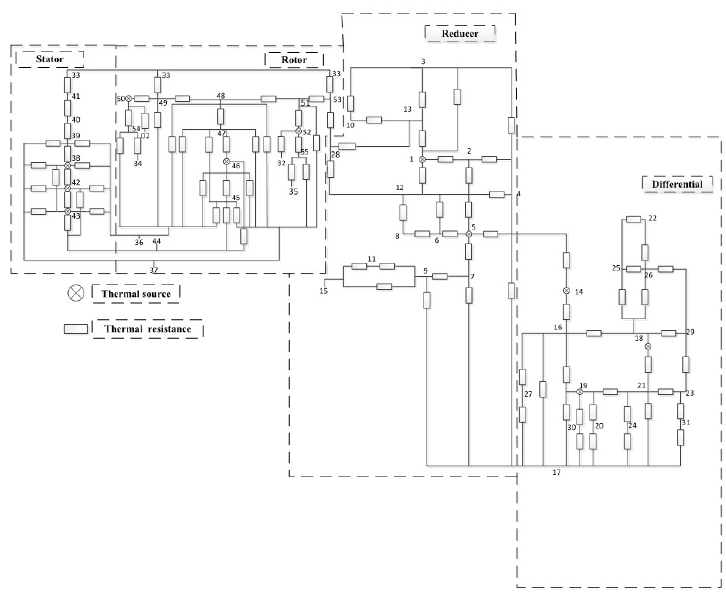
Figure 2. The thermal network diagram of the two-axle automobile drive axle. The fifty-five nodes in Figures 1 and 2 are represented, respectively, in Table 1. Fifty-five nodes in the thermal network diagram.